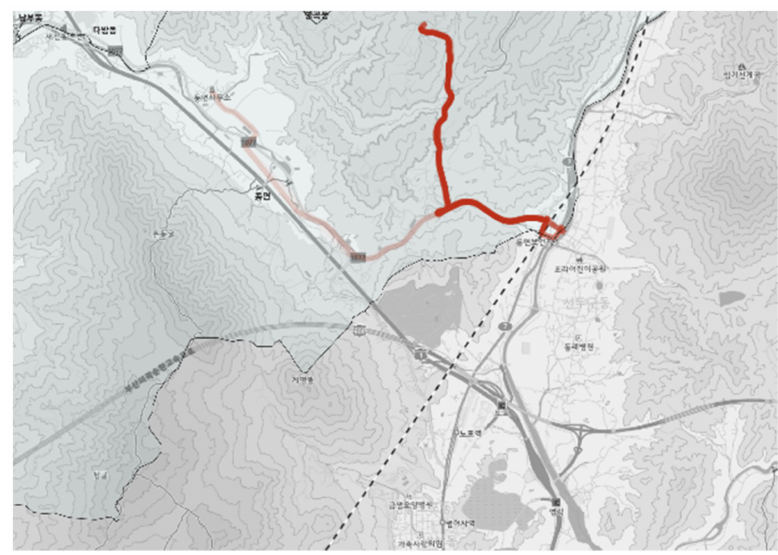
Figure 12. Actual driving record of city-type bus No. 2.